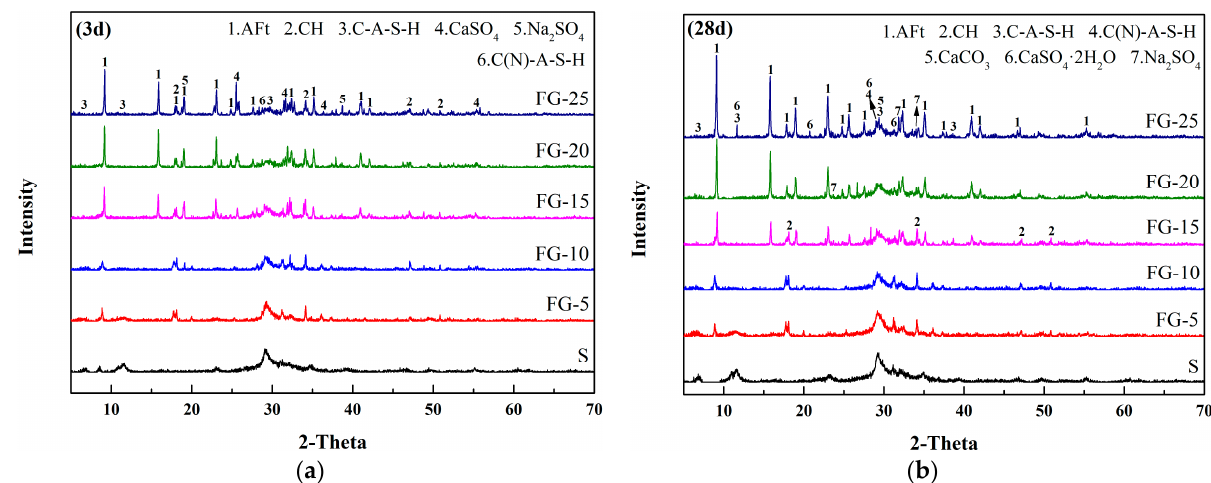
Figure 8. XRD patterns of cement paste with different FG content: ( a ) 3 days; ( b ) 28 days. Crystals 2021 , 11 , 1475